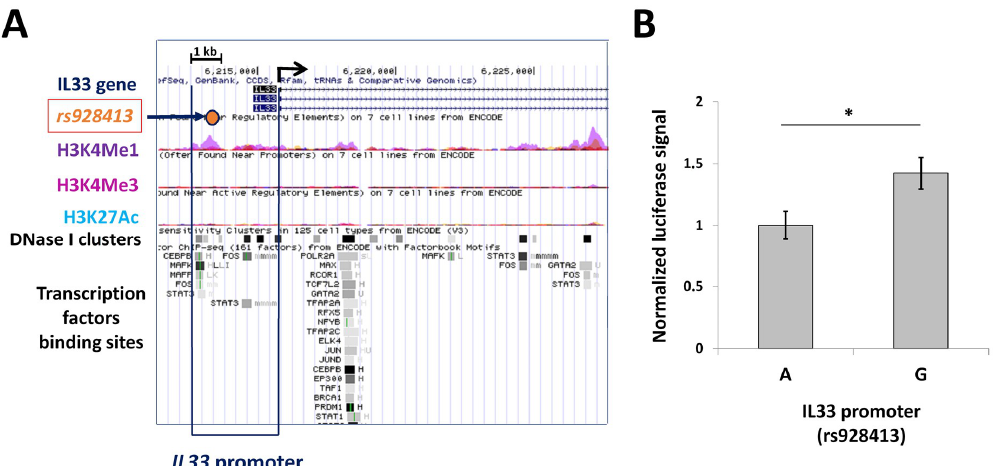
Figure 1. Minor G allele of rs928413 located in human IL33 promoter increases its activity in a luciferase reporter system. ( A ) Illustration of the 5′ area of human IL33 gene (UCSC Genome Browser, GRCh37/hg19 assembly) with selected maps of histone modifications, DNase I hypersensitivity clusters and predicted transcription factors binding sites. H3K4Me1: the track indicating areas of monomethylation of Histone H3 at lysine 4; H3K4Me3: the track indicating areas of trimethylation of Histone H3 at lysine 4; H3K27Ac: the track indicating areas of acetylation of Histone H3 at lysine 27; DNase I cluster: the track indicating deoxyribonuclease I hypersensitivity clusters. Horizontal arrow points to Rs928413 location. Angled arrow indicates transcription start site. ( B ) Rs928413(G) allele of the human IL33 promoter has elevated activity in lung cancer cells. A: IL33 promoter containing Rs928413(A) allele; G: IL33 promoter containing Rs928413(G) allele. The experiment was performed five times. * p < 0.05.